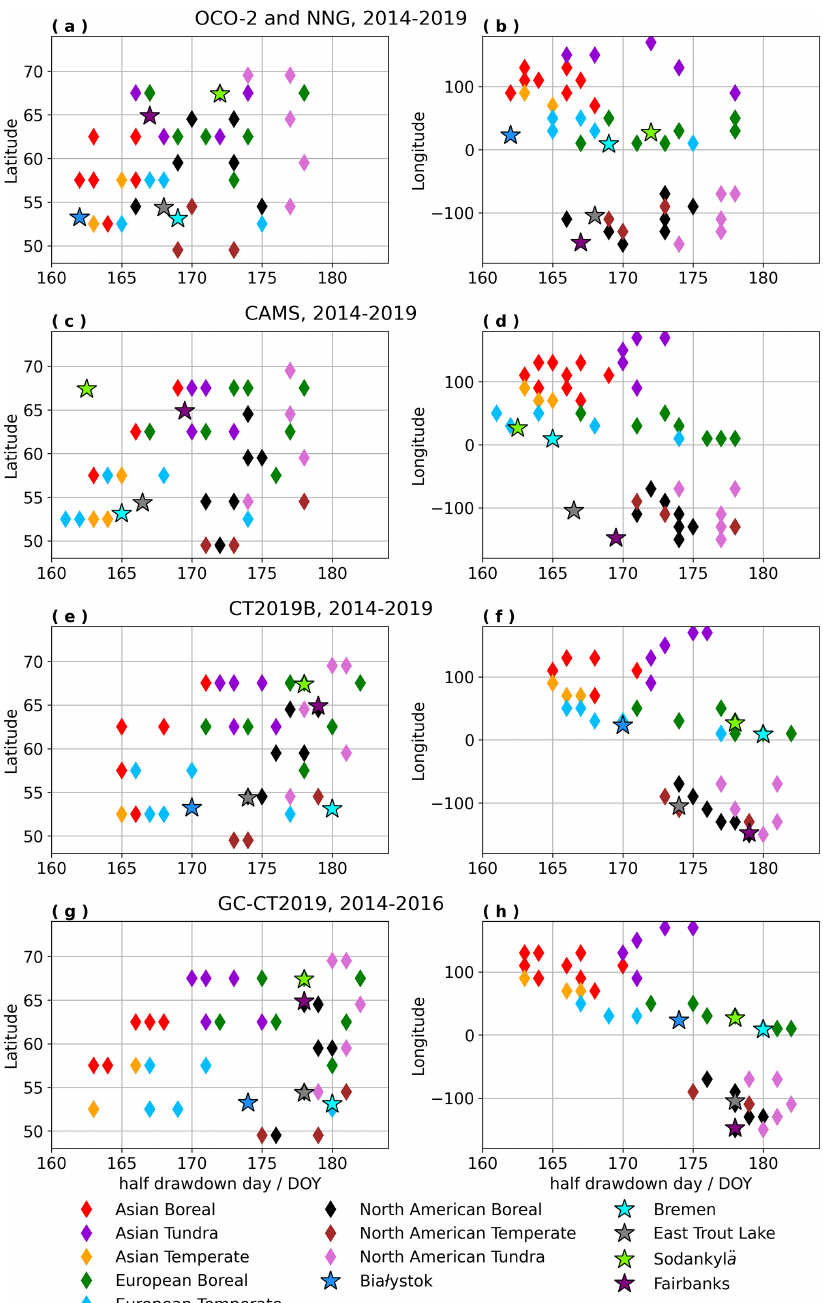
Figure 7. Plots of latitude and longitude correlated to HDD using observational results from OCO-2 and NNG observations (a, b) , CAMS model estimates (c, d) , CT2019B model estimates (e, f) , and GC-CT2019 model estimates (g, h) . The latitude and longitude for each zone is located at its